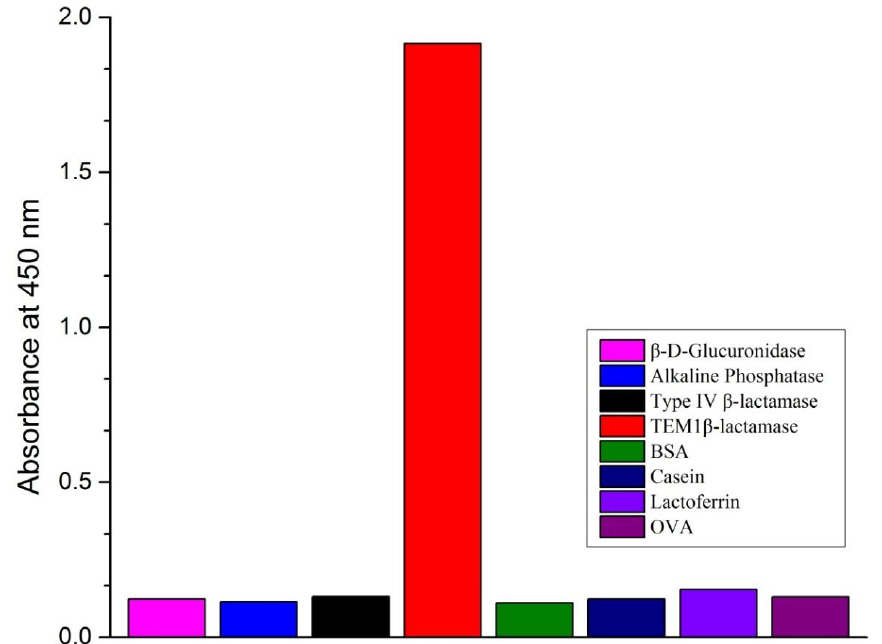
Figure 4. Cross-reactivities of the ELISA toward some enzymes from bacteria and some common proteins. Concentration of TEM1 β-lactamase is 50 ng/mL. Concentration of other reactants is 10